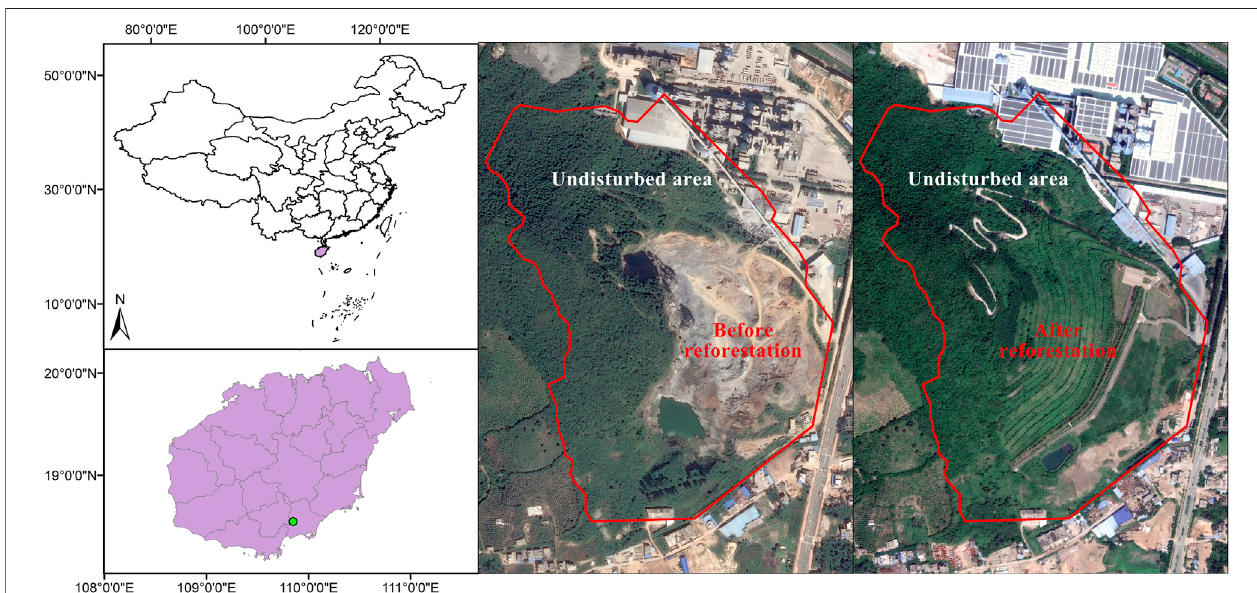
FIGURE 1 | Map of the study site (Baopoling hill, Sanya city, Hainan island, China) and the surrounding landscape of the 0.2 km 2 highly degraded tropical bare hill, both before (A) and after (B) reforestation efforts.